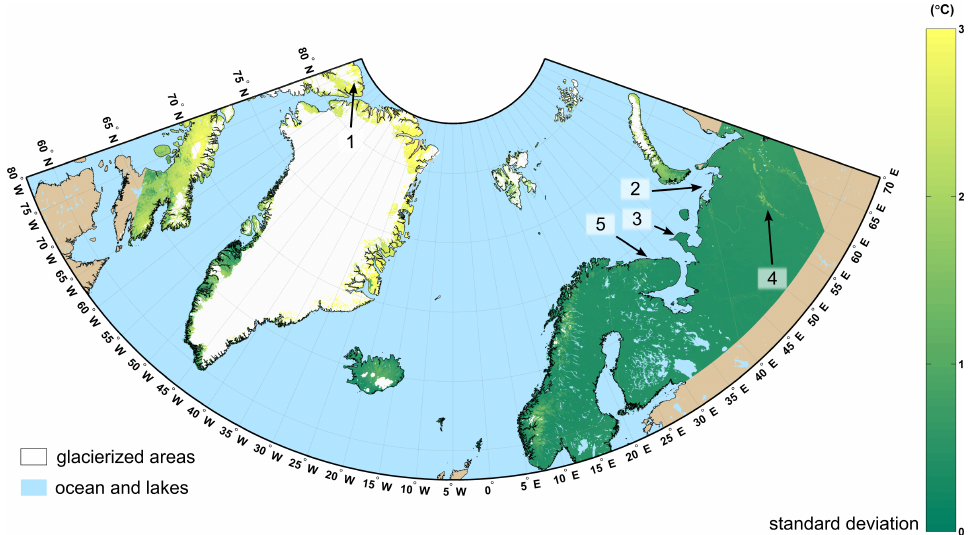
Figure 5. Standard deviation of MAGT of all model realizations for the North Atlantic study region. 1: Ellesmere Island; 2: Pechora Sea; 3: Kanin Peninsula; 4: Ural Mountains; 5: Kola Peninsula. Glacierized areas from Natural Earth